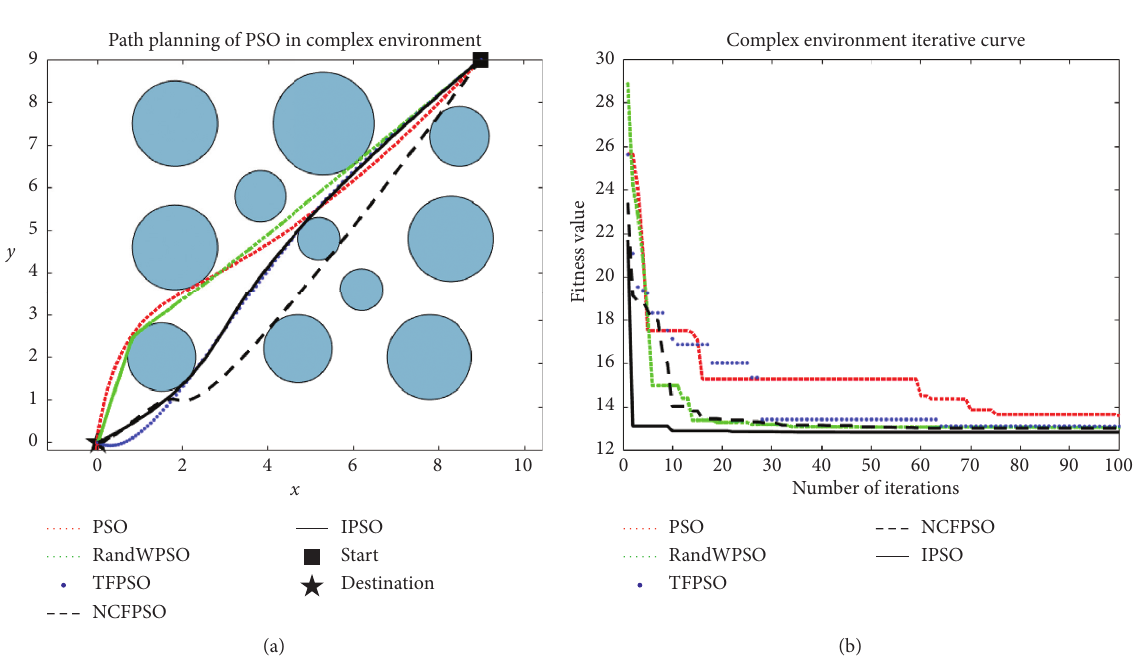
Figure 5: The second experimental comparison of five algorithms in the complex environment. (a) The second type of complex envi- ronment path planning diagram. (b) The second type of complex environment iteration graph. Table 5: The second comparison of path length of five algorithms in the complex environment.